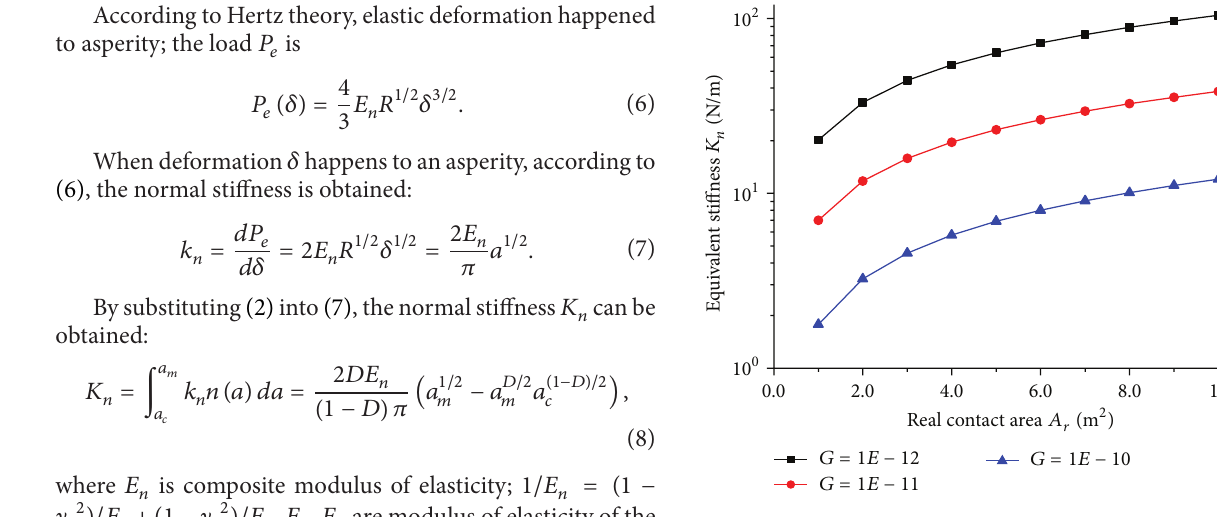
Figure 4: Relationship between 𝐾 𝑛 and 𝐴 𝑟 when 𝐷 = 1.4